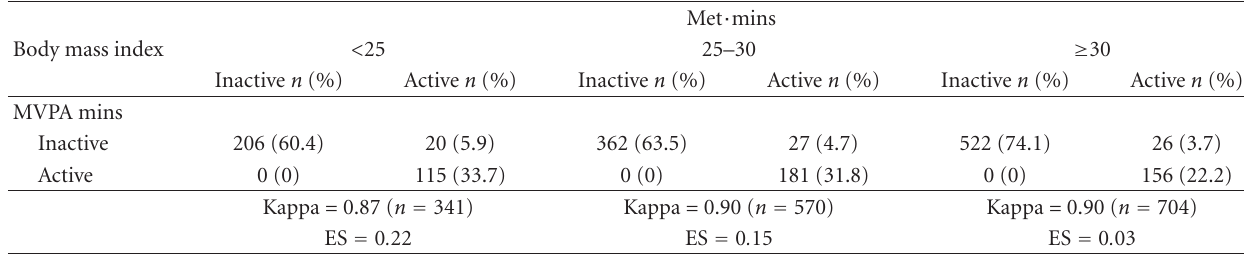
(c) Comparison of agreement between MVPA mins method and Met · mins method across BMI